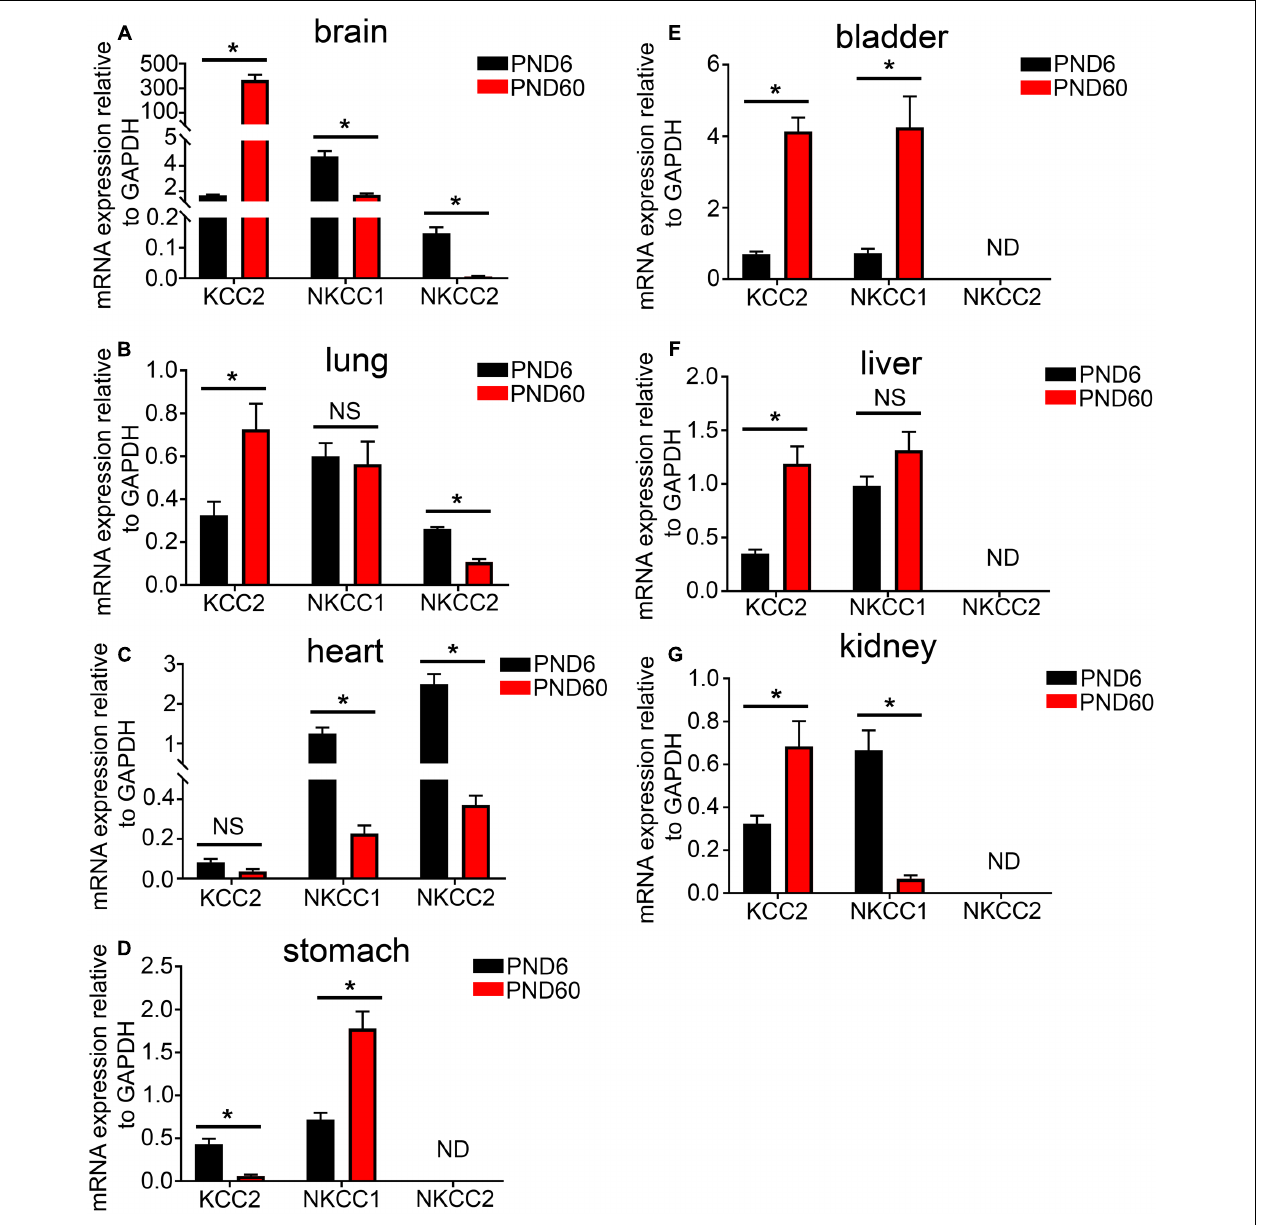
FIGURE 3 | Developmental changes in the mRNA expression level of the KCC2, NKCC1, and NKCC2 chloride ion transporters within various peripheral organs. Quantification of the mRNA expression levels of the potassium-chloride transporter member 5 (KCC2), Na–K–Cl cotransporter 1 (NKCC1), and Na–K–Cl cotransporter 2 (NKCC2) in tissue from mice aged postnatal day 6 (PND 6) and adulthood (PND 60), using qPCR. Within the (A) brain, (B) lung, and (C) heart, a significant increase in KCC2 was detected and a decrease in the NKCCs mRNA levels as the mice age. However, within the (D) stomach, the contrary is true. In addition, there is an increase in both KCC2 and NKCCs mRNA expression levels from PND 6 to 60 within the mouse bladder (E) and liver (F) . Within the mouse (G) kidney, KCC2 mRNA is expressed at very low levels in compare to the NKCCs and aging induces a decrease in the expression of NKCCs. Data represent mean ± SEM; N = 5 animals. NS, not significant; ND, not detected. ∗ P < 0.05, Student’s unpaired t -test.